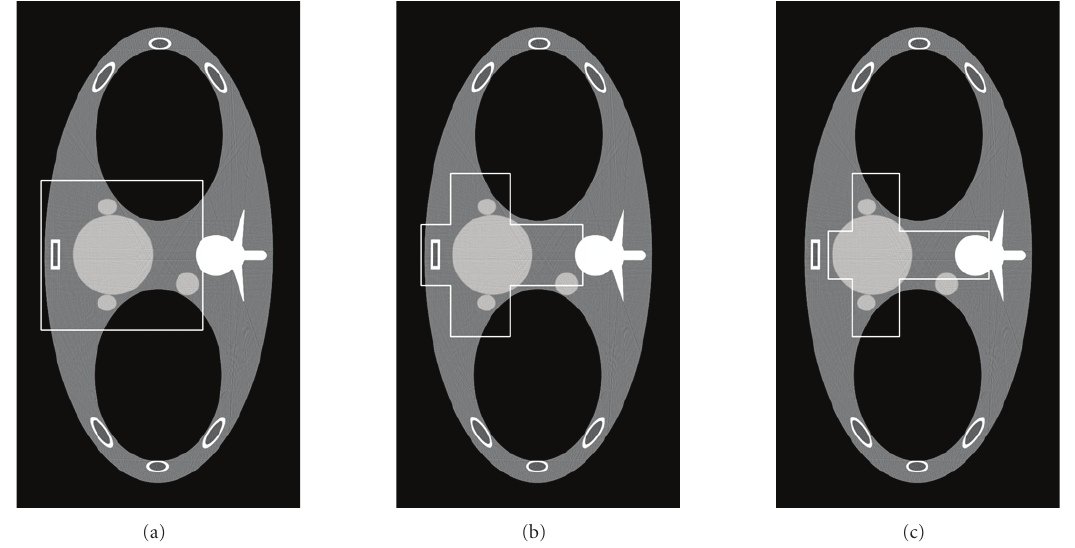
Figure 4: Representative slice of the thorax phantom reconstructed from a complete dataset. (a) A rectangular ROI for reproducing the results by Defrise et al.; (b) and (c) are two cross-shaped ROIs for evaluating our truncated Hilbert transform technology.